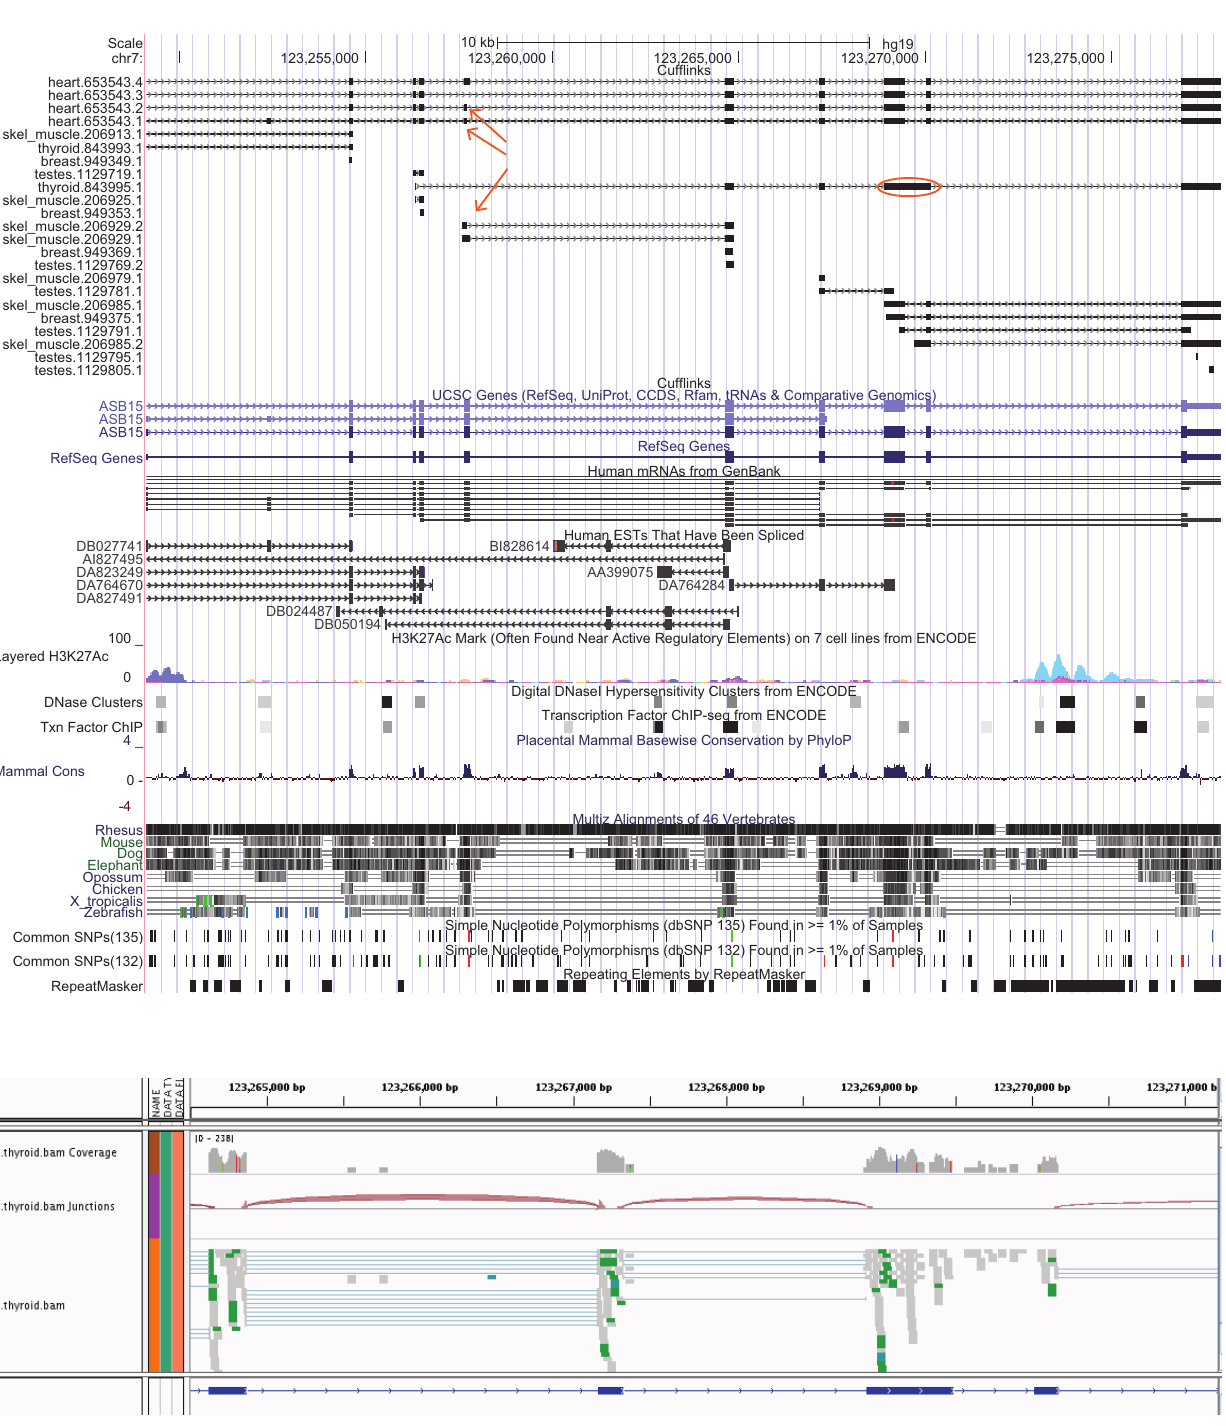
Figure S10. Novel exon skipping event at the human ASB15 gene locus. (Top) Exon chr7:123,257,633–123,257,718, present in heart (heart.653543.1 and heart.653543.2) and with partial support in skeletal muscle tissue (skel_muscle.206929.2), is novel. Red arrows point to the exon appearing in two isoforms reconstructed in the heart sample, and to the (potentially) partial form in a skeletal muscle transcript for the ASB15 gene. The spanning intron in the heart sample is also novel. Additionally, we found a potentially retained intron (chr7:123,269,489–123,270,019; thyroid.843995.1), circled in red, whose 531 bp sequence is conserved across multiple vertebrates. (Bottom) Read support for the putative intron retention event above in the thyroid sample, whereas the flanking introns are devoid of intronic reads. RefSeq exon annotations are shown in